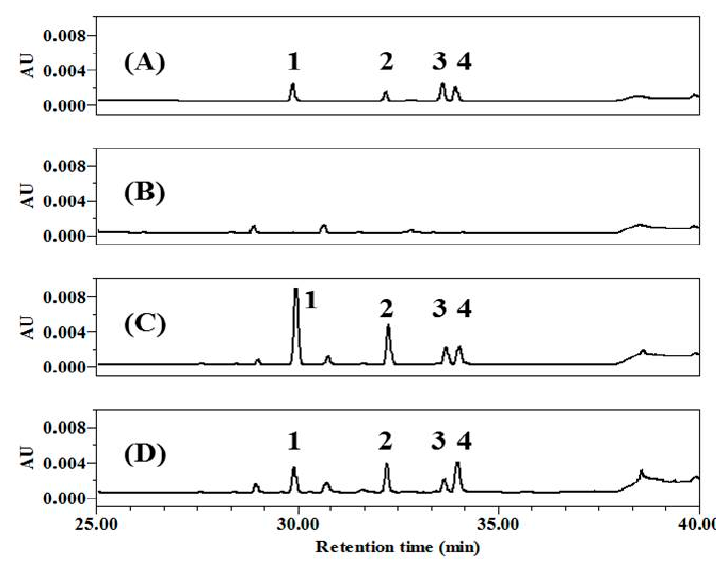
Figure 1. High-performance liquid chromatography (HPLC) analysis of theaflavins (TFs). ( A ) Standard chemicals; ( B ) Green tea extract; ( C ) co-fermented green tea (CoF-GT) fraction; ( D ) fermented green tea (F-GT) fraction. Data were monitored at 270 nm and compounds were assigned as follows: Peak 1, theaflavin (TF); Peak 2, theaflavin-3-gallate (TF3G); Peak 3, theaflavin-3’-gallate (TF3’G); and Peak 4, theaflavin-3,3’-digallate (TFDG).